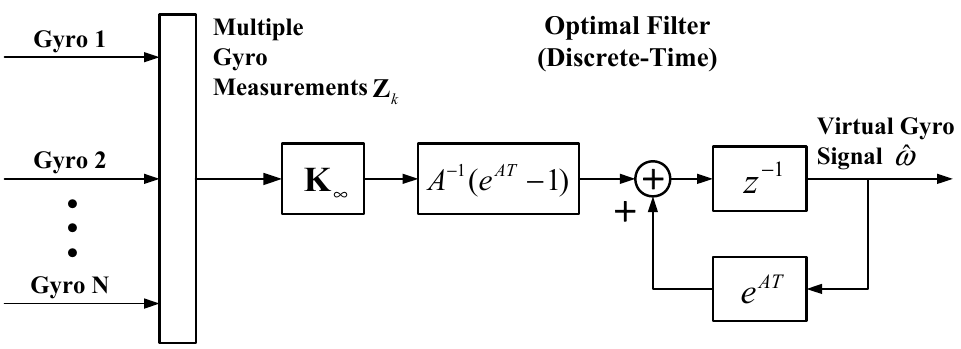
Figure 2. Virtual gyroscope implementation using a discrete